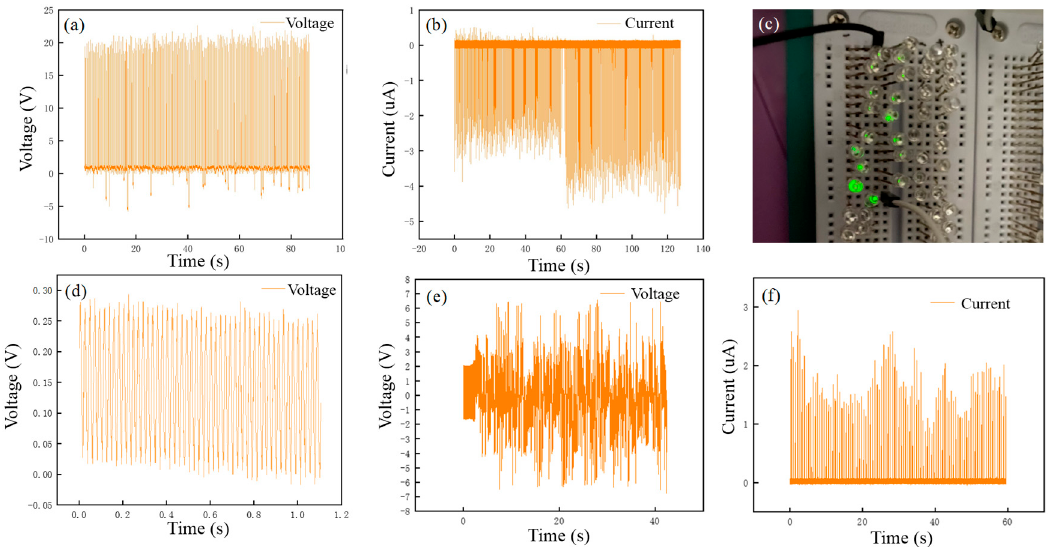
Figure 8. ( a ) Generated Voc from superhydrophobic coating with an aluminum electrode. ( b ) Generated Isc from superhydrophobic coating with an aluminum electrode. ( c ) The image of the LEDs lit up by water droplet. ( d ) Generated Voc from superhydrophobic coating without aluminum electrode. ( e ) Generated Voc from the coating without modified SiO 2 . ( f ) Generated Isc from the coating without modified SiO 2 .